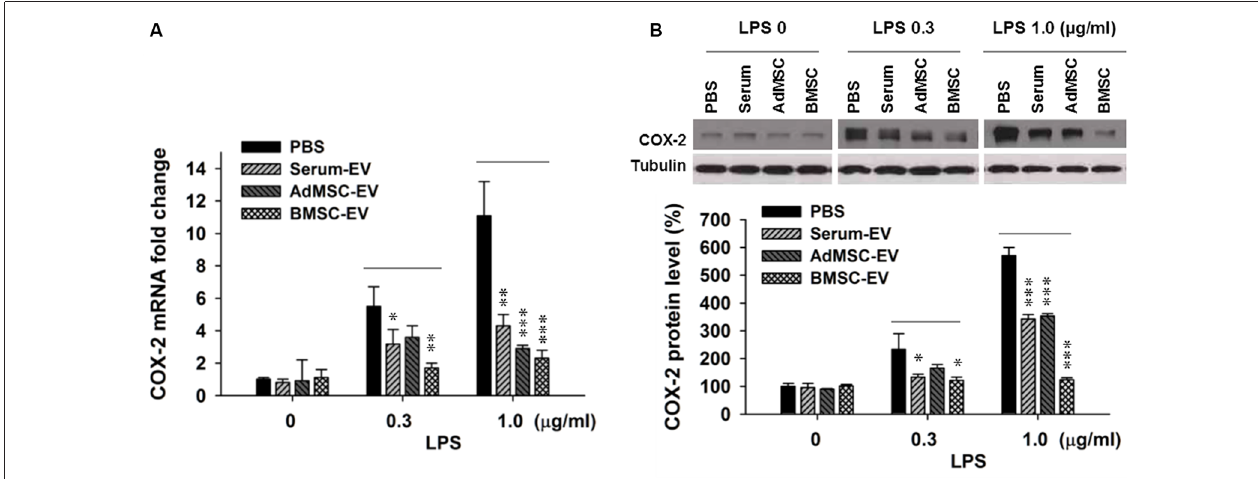
FIGURE 1 | Effects of extracellular vehicles (EVs) on lipopolysaccharides (LPS-induced) cyclooxygenase-2 (COX-2) expression at mRNA and protein levels in mixed neuron-glial primary cultures. (A) EVs derived from serum (serum-EV), adipose mesenchymal stem cells (AdMSC-EV) and bone marrow MSC (BMSC-EV) significantly suppressed LPS (0.3 µ g/ml and 1.0 µ g/ml) -induced up-regulation of COX-2 mRNA level, as compared to phosphate-buffered saline (PBS) treatment (LPS 0.3 µ g/ml: PBS = 5.7 ± 0.6, serum-EV = 3.3 ± 0.6, AdMSC-EV = 3.8 ± 0.5, BMSC = 1.9 ± 0.2). (B) EVs from three sources significantly inhibited LPS-induced COX-2 at protein level. The three straight lines above sample blot images indicate the three groups of LPS treatment at the concentrations of 0, 0.3 and 1.0 µ g/ml (LPS 0.3 µ g/ml: PBS = 243 ± 51%, serum-EV = 132 ± 10%, AdMSC-EV = 179 ± 14%, BMSC = 127 ± 13%). n = 7 tests per group. Data show means ± SEM. One-way ANOVA analysis followed by a Tukey’s post hoc test. ∗ p < 0.05, ∗∗ p < 0.01 and ∗∗∗ p < 0.001.